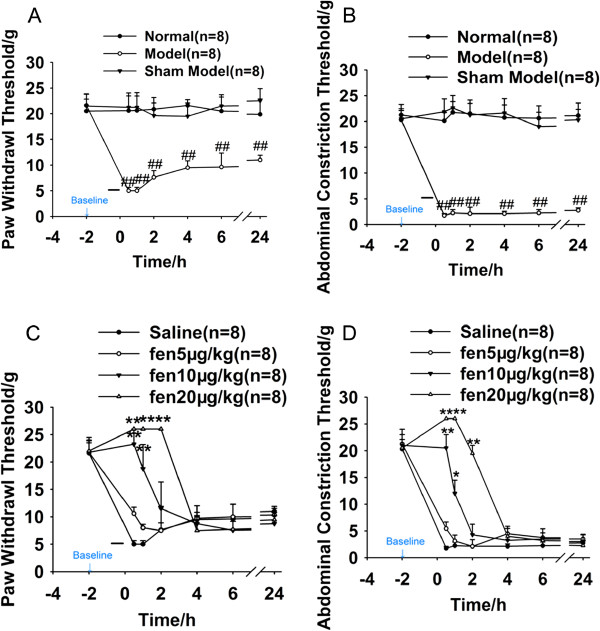
Mechanical threshold changes (in grams) after surgery with or without intramuscular injection of fentanyl are presented as the mean ± SEM at the indicated time points post-surgery. A, B: abdominal and paw mechanical changes among normal, sham model and model groups after surgery. C, D: abdominal and paw mechanical changes among saline, fentanyl 5, 10 and 20 μg/kg groups. ##P<0.01 versus the sham model group, #P<0.05 versus the sham model group; *P<0.05, **P<0.01 versus the saline group. Short black lines represent the surgery duration. Fen: fentanyl, BL: baseline.